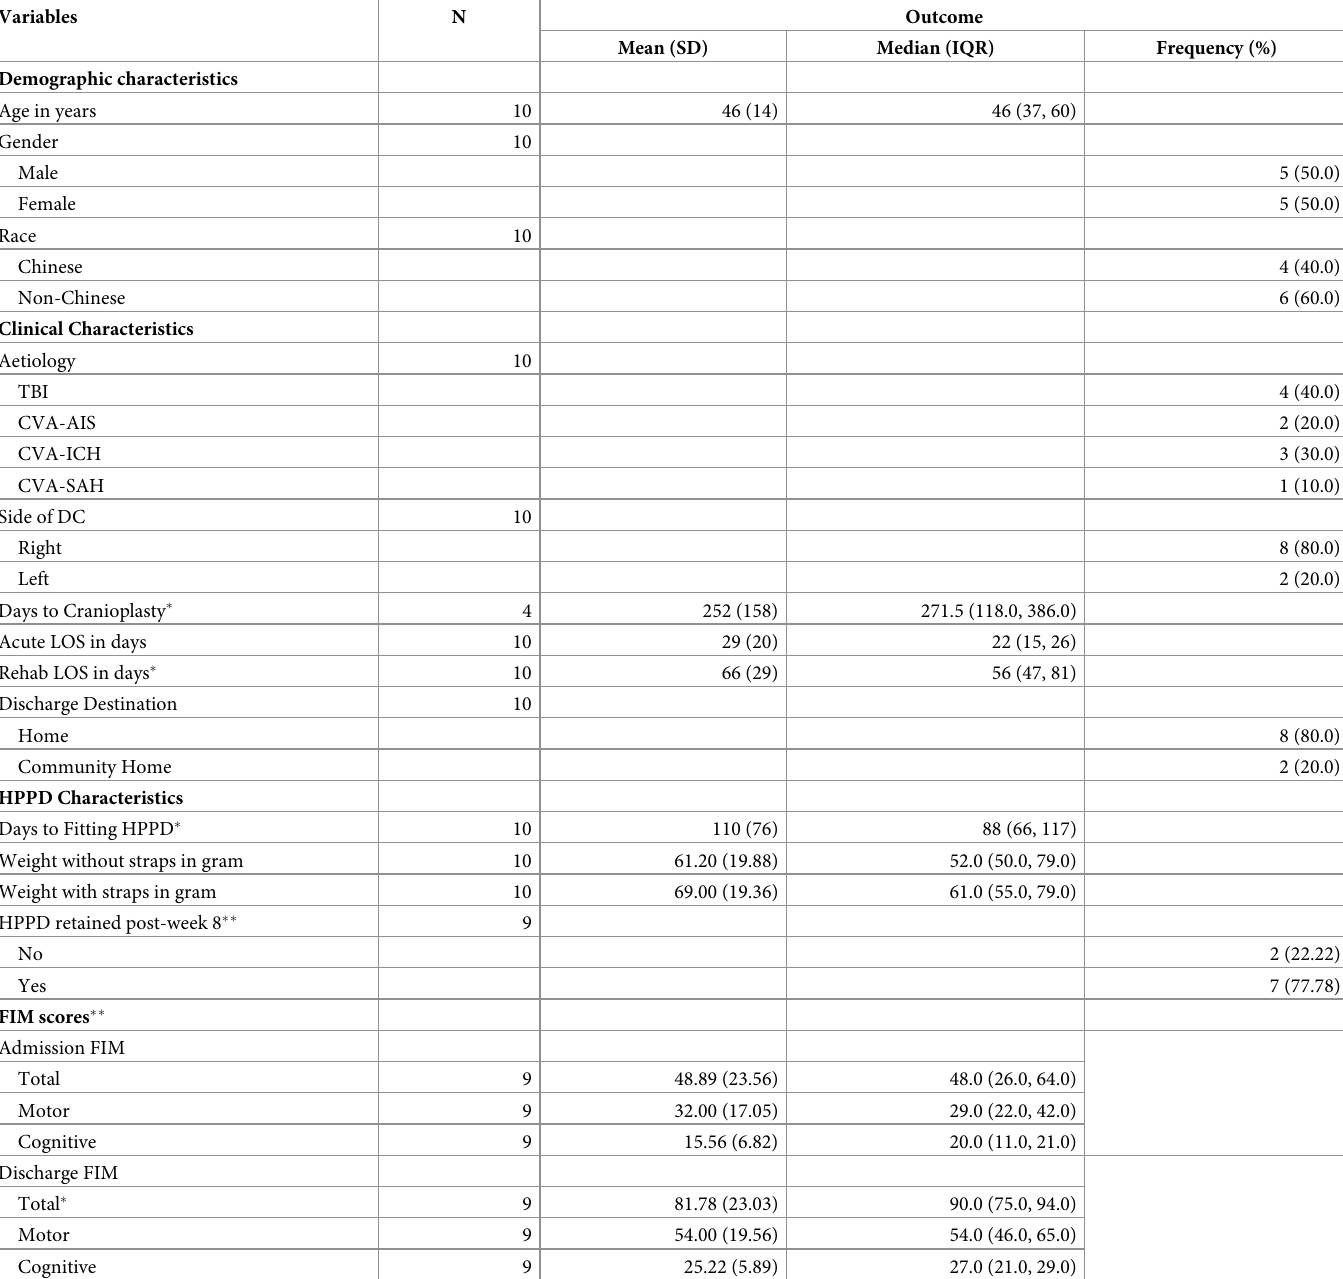
Table 2. Summary of baseline demographic, clinical and HPPD